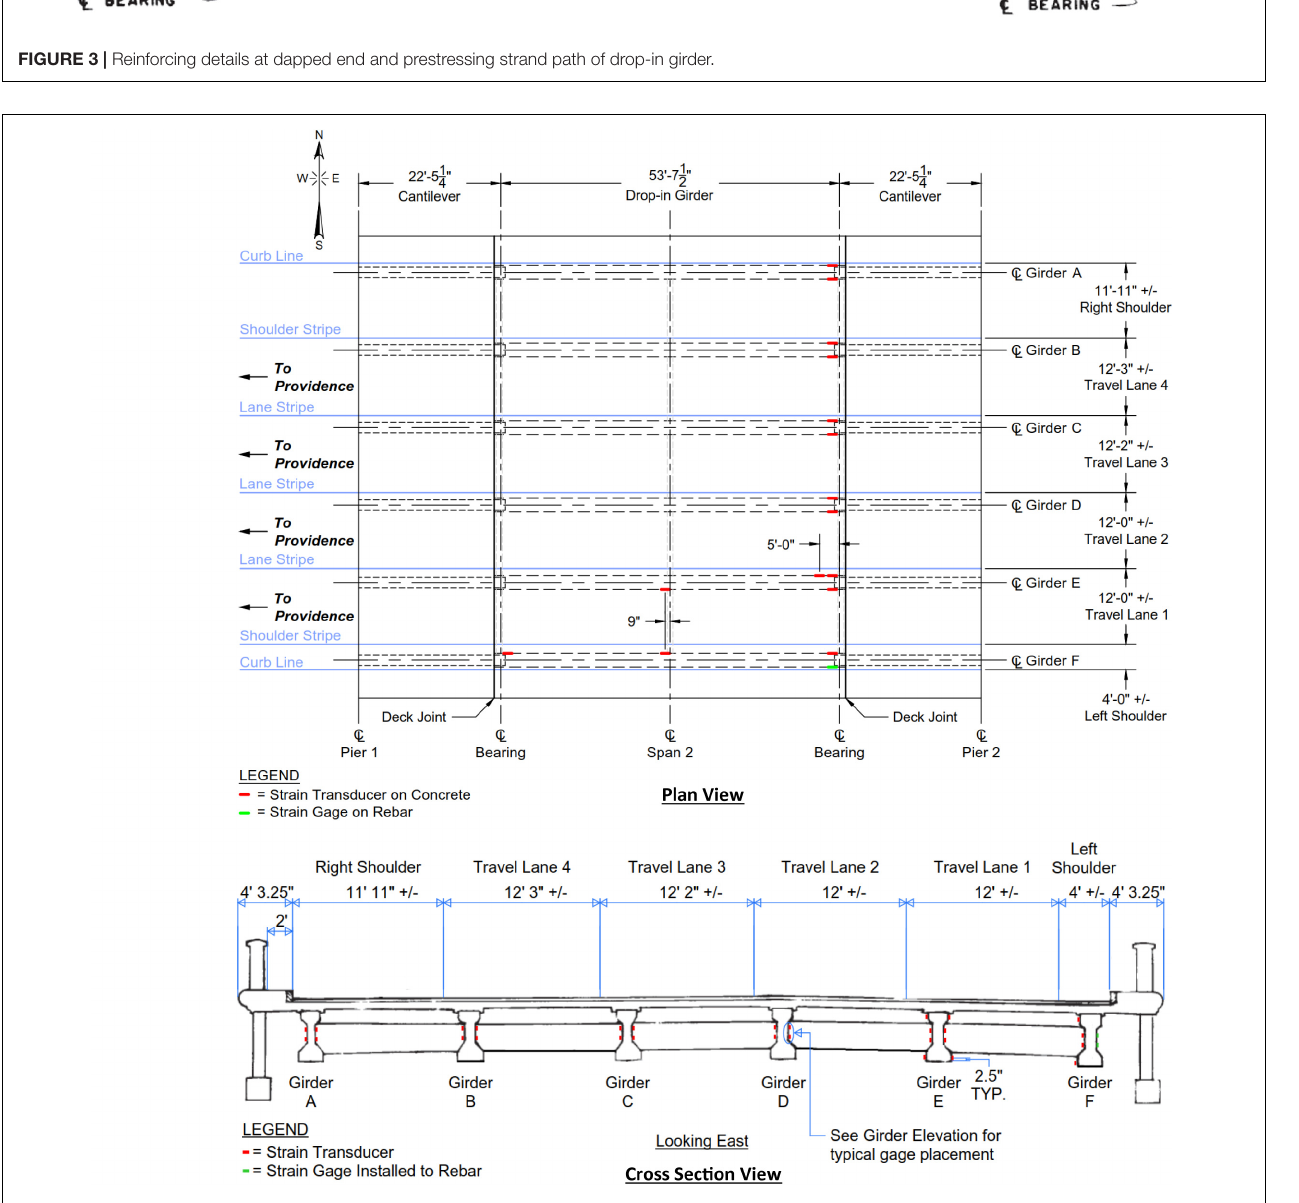
FIGURE 4 | Layout of 32 strain sensors on six drop-in